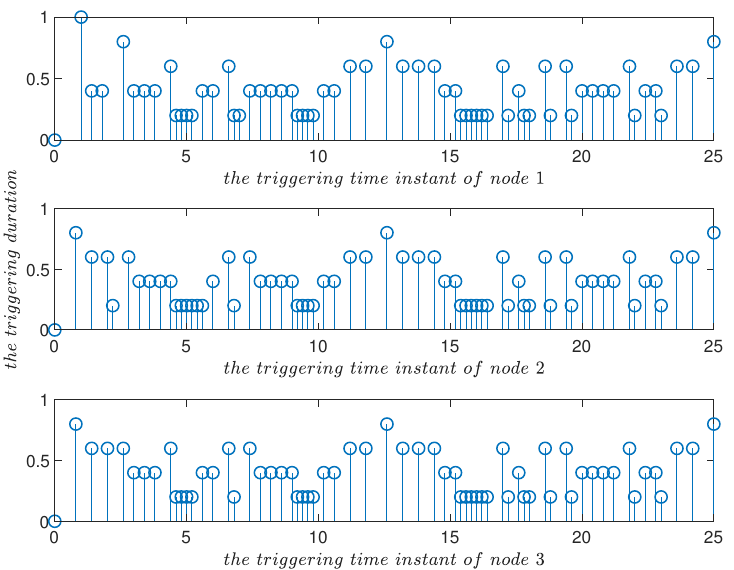
Figure 14. Triggering time instants and their duration of the event-triggered scheme in Example 2. When the triggering parameters could be switched, the triggering time instants and their duration are displayed.